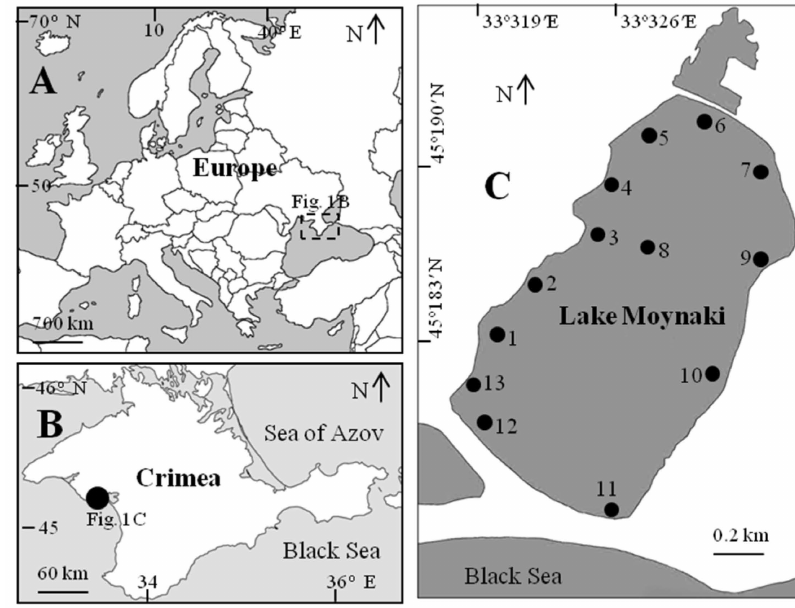
Figure 1. Lake Moynaki and sampling